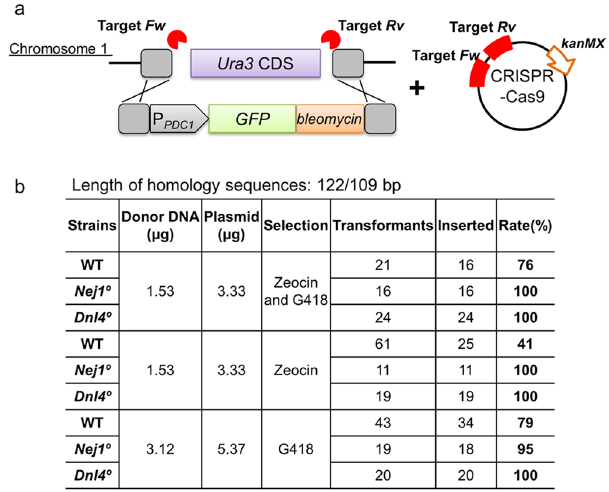
Figure 4. Homologous recombination facilitated by CRISPR-Cas9. ( a ) Schematic of the transforming donor DNA fragment targeting the Ura3 locus and CRISPR-Cas9 plasmid targeting two sites (indicated by lightning bolts) flanking the Ura3 coding sequences (CDS). Dashed boxes indicate homologous regions. Bottom panel indicates ( b ) Homologous recombination rate (5-FOA resistant (inserted)/zeocin and/or G418 resistant (transformants) * 100).